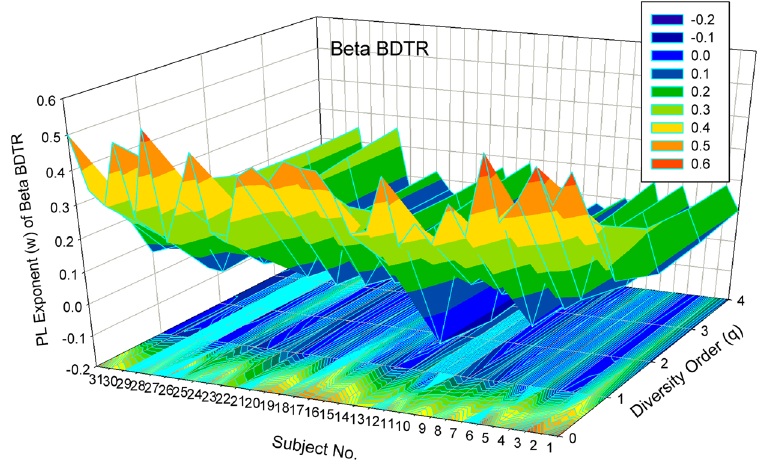
Figure 2. The 3D-graph of the power law exponent ( w ) of beta -